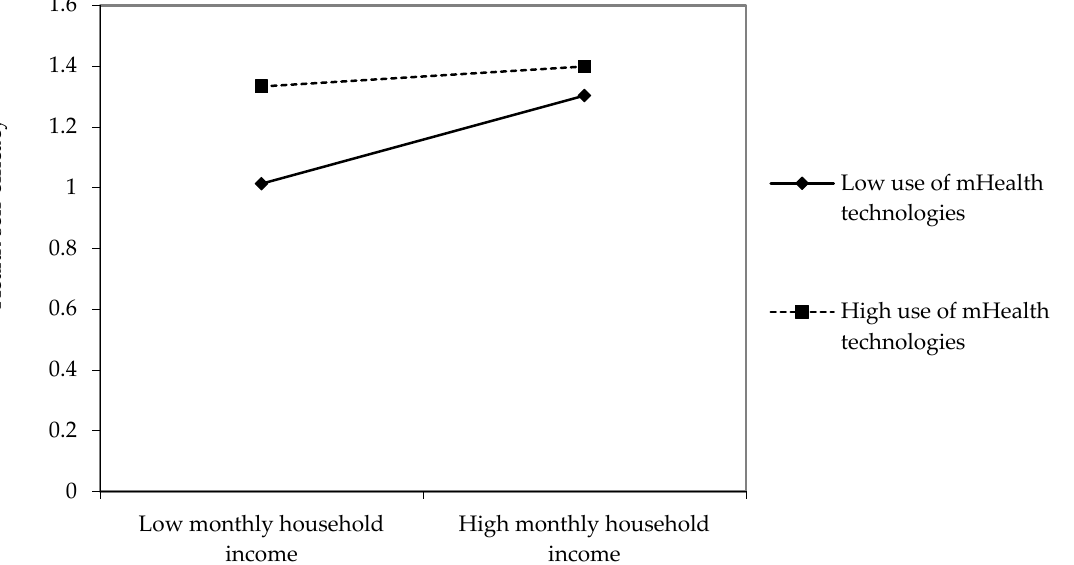
Figure 2. Interaction effects between monthly household income and use of mHealth technologies on health self-efficacy.